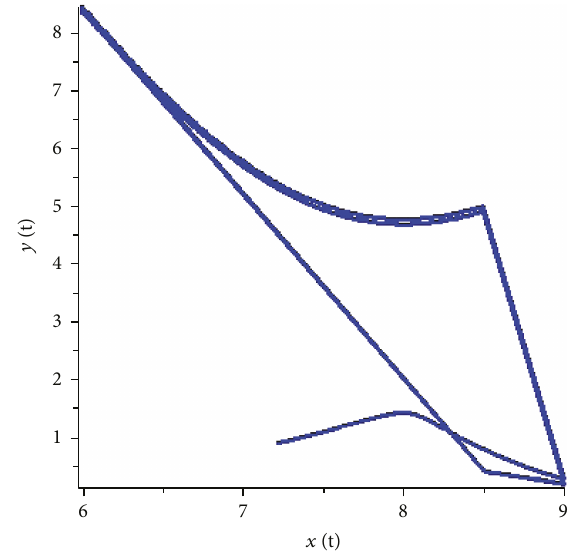
Figure 25: There exists an order-2 periodic solution in system (16) with q 1 = 1/18 , p = 0 95 , and τ = 4 7